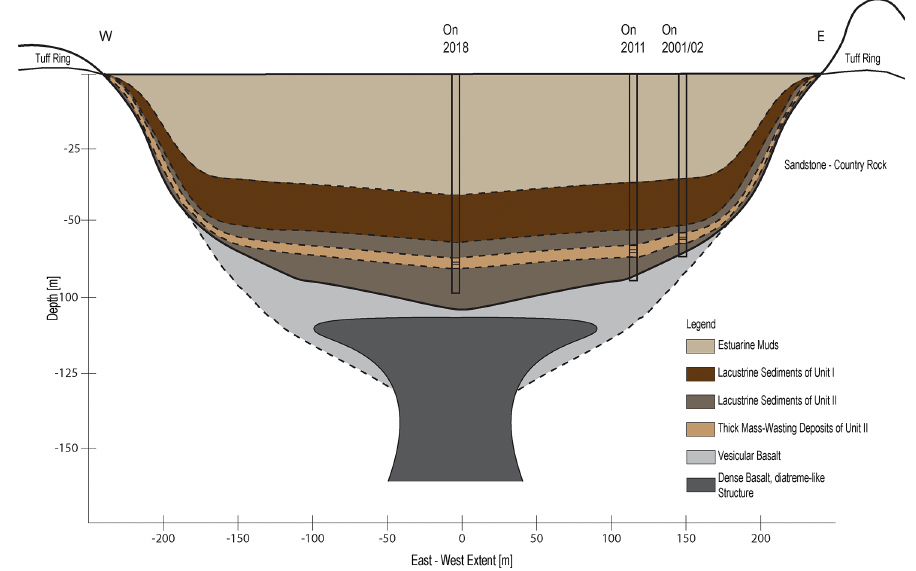
Figure 4. Cross-section of the crater and its infill. Extent and position of diatreme-like structure under the crater and vesicular basalt at depth guided by descriptions in Nunns and Hochstein (2019) as well as drill core findings (On2011, On2001/02) for the latter. Thickness and lateral extent of major lithostratigraphic units taken or estimate based on drill core findings (On2018, On2011, and On2001/02).